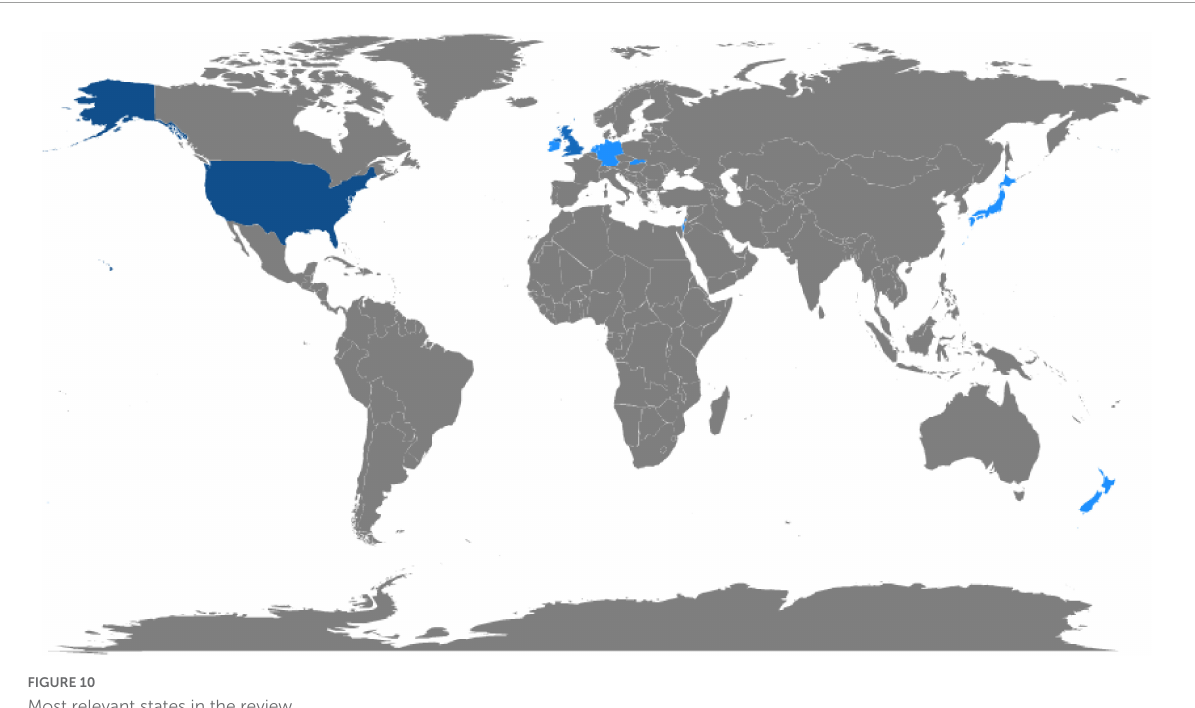
FIGURE10 Most relevant states in the